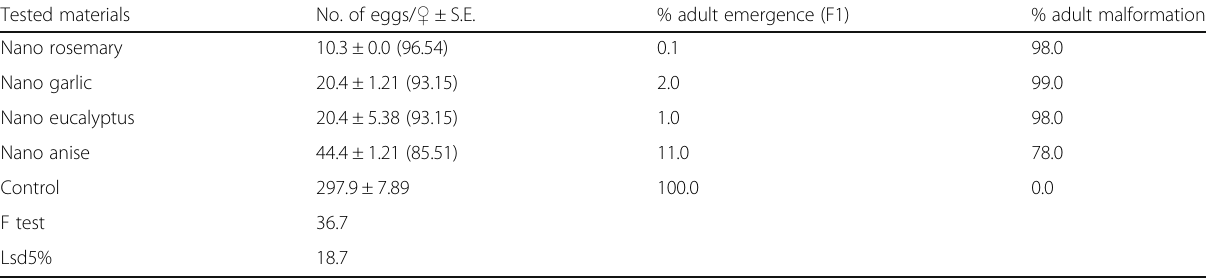
Table 3 Effect of nano oils on number of laid eggs/female, % adult malformation, and % of adult emergence (F1) of E. cutella during